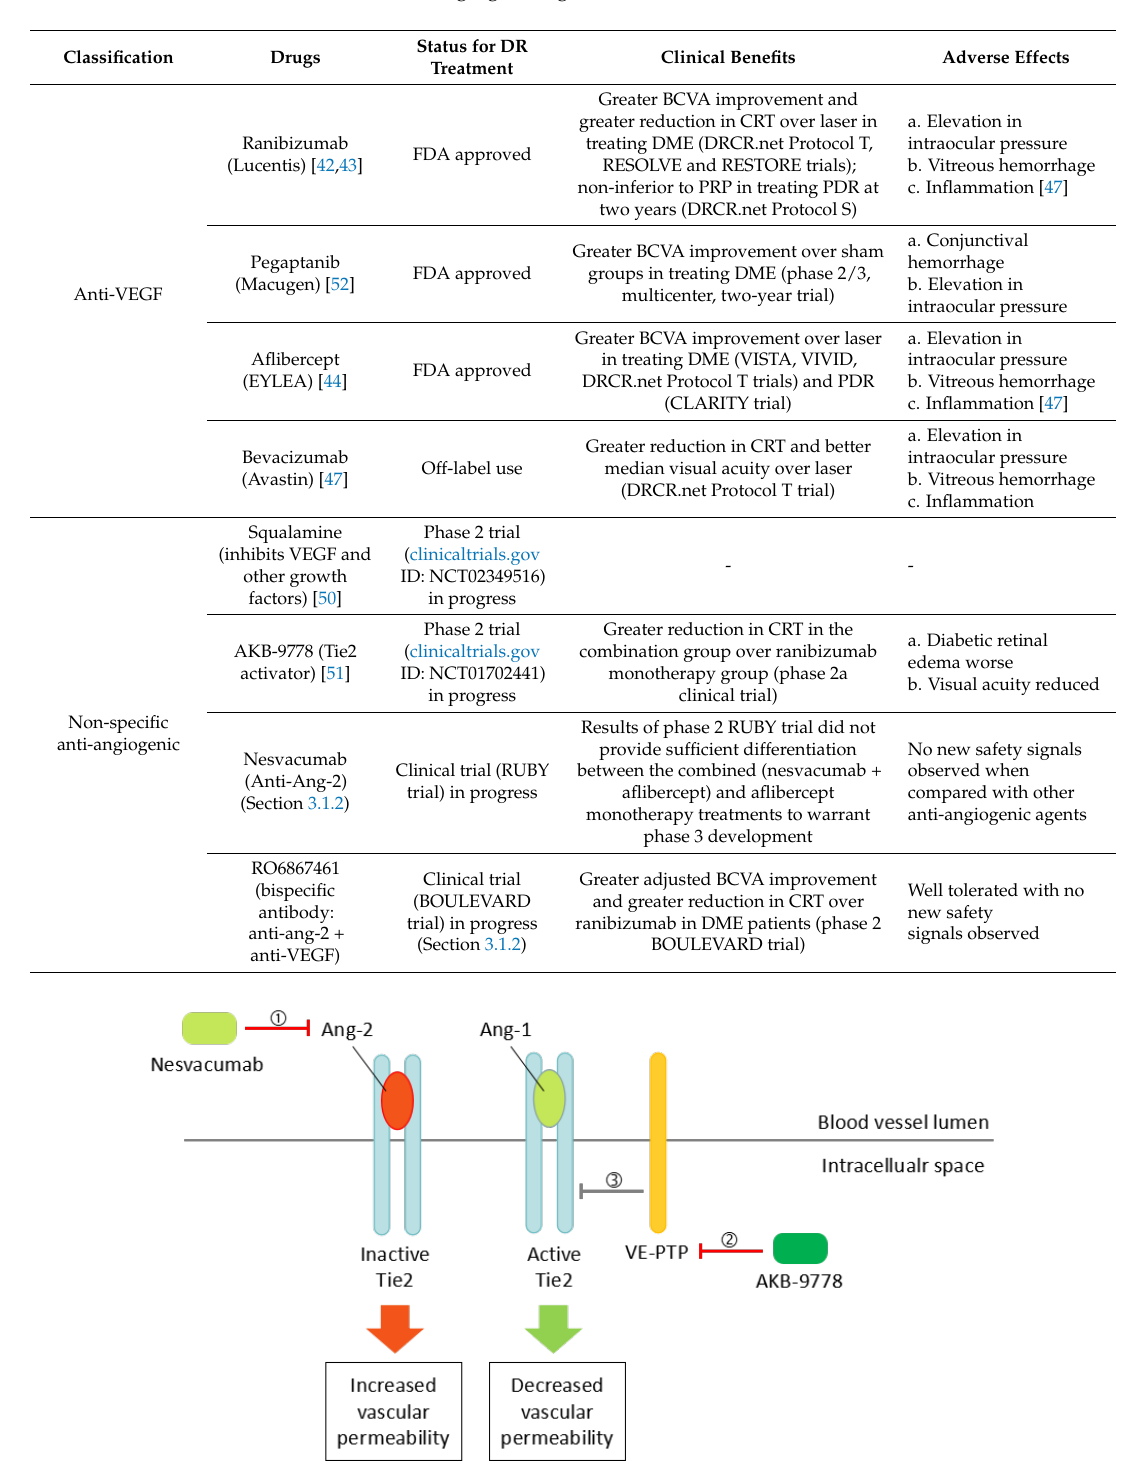
Figure 1. Nesvacumab activates Tie-2 signaling and decreases vascular permeability by inhibiting Ang-2, an antagonist of Tie2. AKB-9778 activates Tie-2 signaling by inhibiting VE-PTP, a negative regulator of Tie-2.